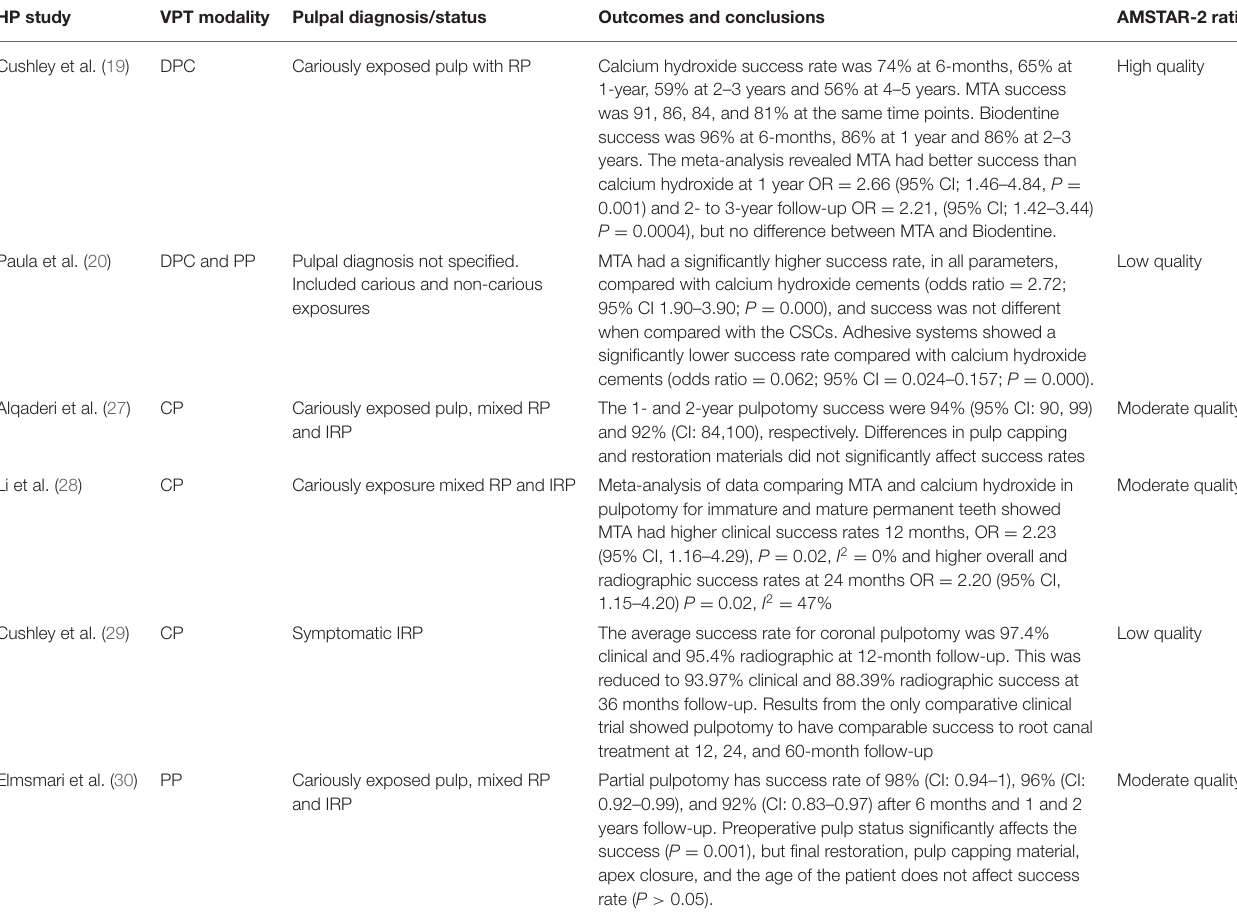
TABLE 1 | Summary of evidence from recent systematic reviews on VPT studies on permanent teeth assessed using AMSTAR-2